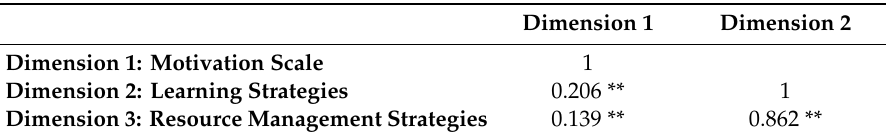
Table 6. Correlation between